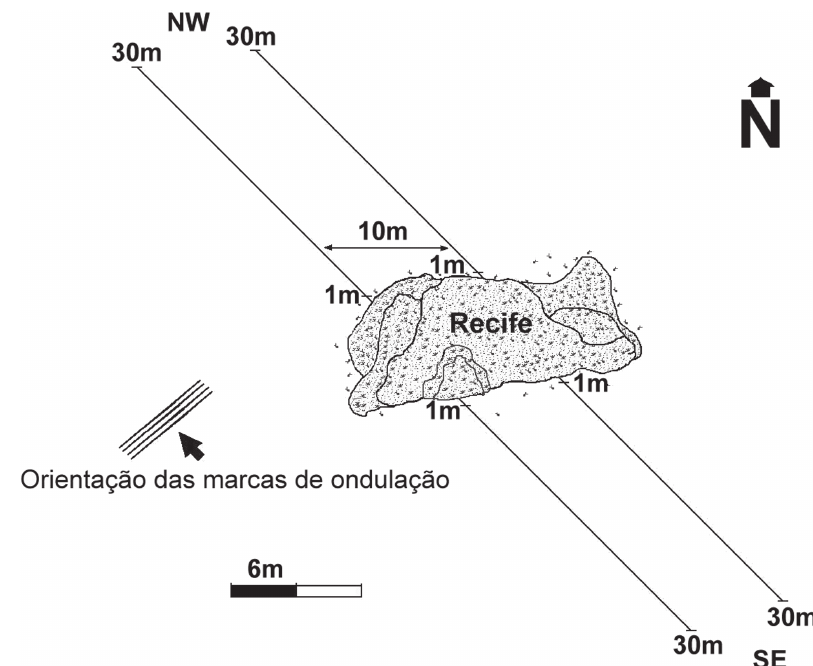
Figura 2. Esquema da amostragem indicando as faces, os transectos e os distanciamentos da